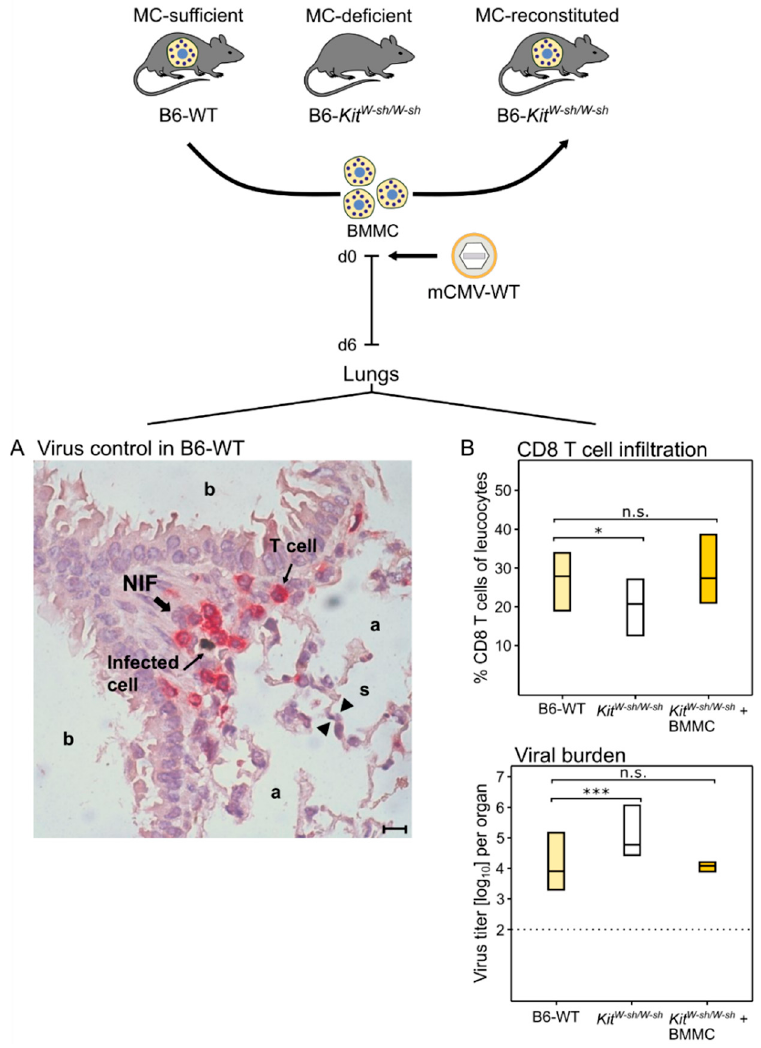
Figure 2. (Top) Experimental protocol. (BMMC) Bone-marrow-derived MC. MC-deficient mice were reconstituted by intravenous infusion of BMMC derived from MC-sufficient donors. Experiments were performed 4 weeks after engraftment. ( A ) Two-color immunohistological image showing the confinement of lung infection by CD8 T cells in a nodular inflammatory focus (NIF) on day six after intravenous infection of MC-sufficient B6-WT (wild-type) mice; (a) alveoli lined with alveolar epithelium; (b) bronchioles lined with bronchiolar epithelium; and (s) alveolar septum. The bar marker represents 10 µ m. ( B ) Inverse correlation between CD8 T-cell tissue infiltration and control of lung infection. Bars represent the range of data from individual mice with the median values indicated. (Light yellow bars) Constitutively MC-competent B6-WT mice; (open bars) MC-deficient sash mutants; (dark yellow bars) MC-deficient sash mutants made MC-competent by reconstitution with BMMC. (n.s.) Not significant; (*) p < 0.05; (***) p < 0.001. Results are displayed schematically and in a new arrangement based on original data published in